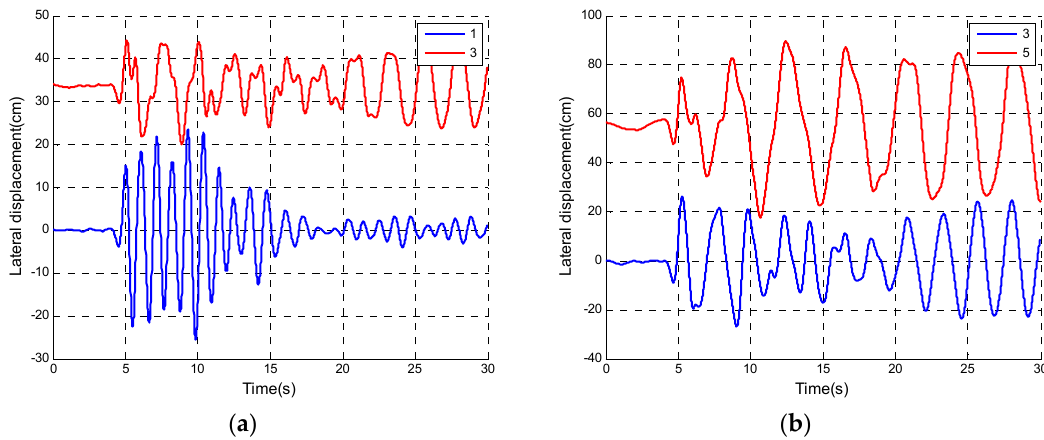
Figure 6. Examples of the results of the validation analysis under the Loma Prieta earthquake record: ( a ) arrangement 1-3, seismic gap: 33.9 cm, ( b ) arrangement 5-3, seismic gap: 56.26 cm.